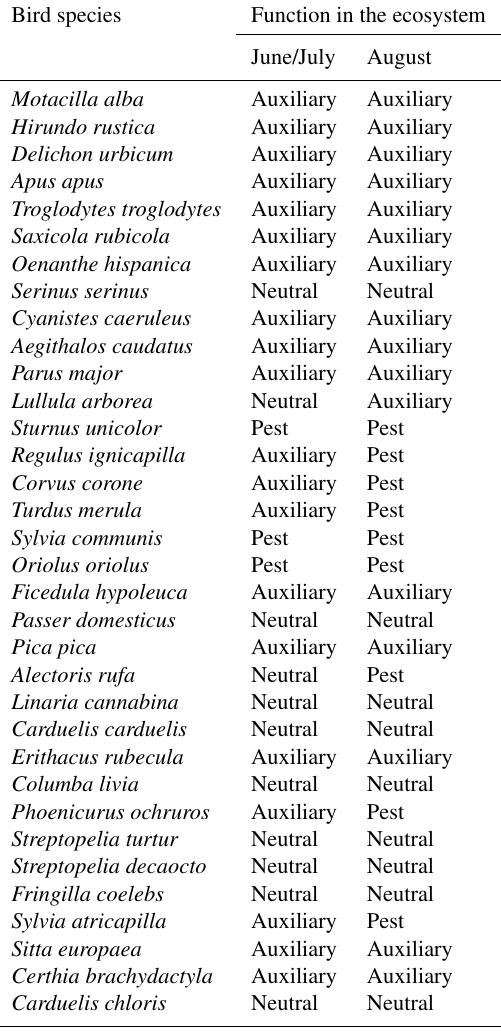
Table A1. Bird species sampled in each month according to their function in the ecosystem.